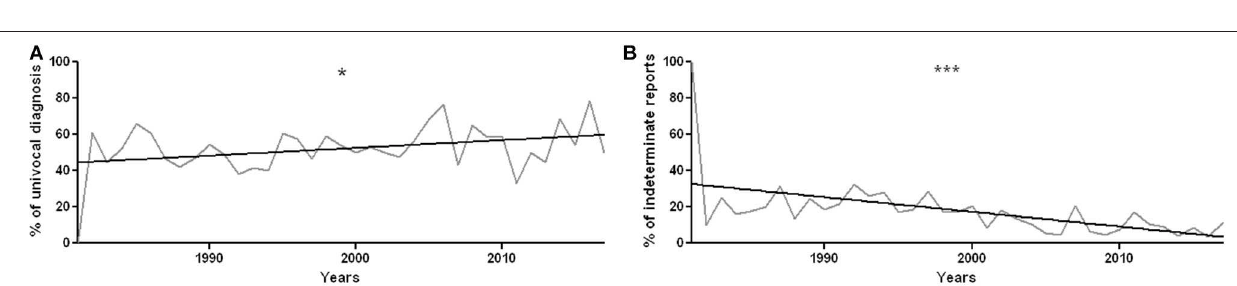
FIGURE 4 | (A) Percentage of definite diagnoses year by year, from 1981 to 2017. There is a statistically significant increase in univocal diagnoses, with r 2 = 0.12 and p = 0.04. (B) Percentage of undetermined reports over the years. The decrease in the percentage of undetermined reports is statistically significant, with r 2 = 0.3010 and p = 0.0004. * p < 0.05 and *** p <